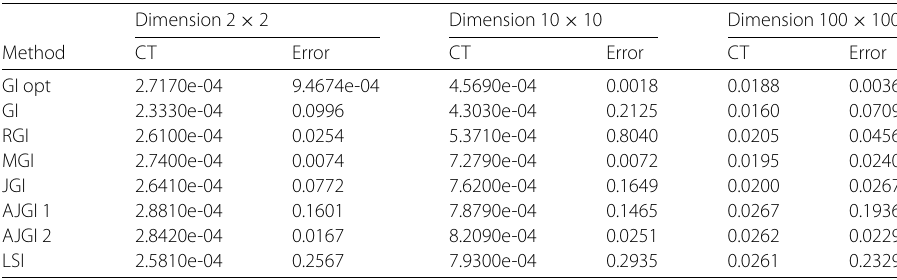
Table 3 Relative error and computational time for Example 5.3